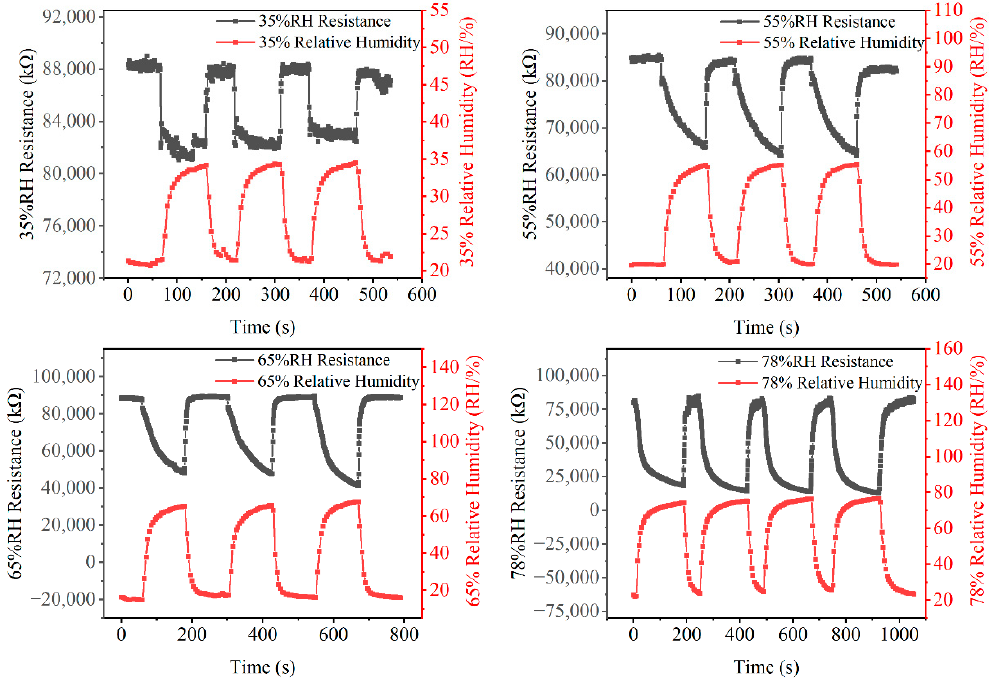
Figure 9. Comparison of humidity response between copper humidity sensor and commercial humidity sensor under various RH environments.